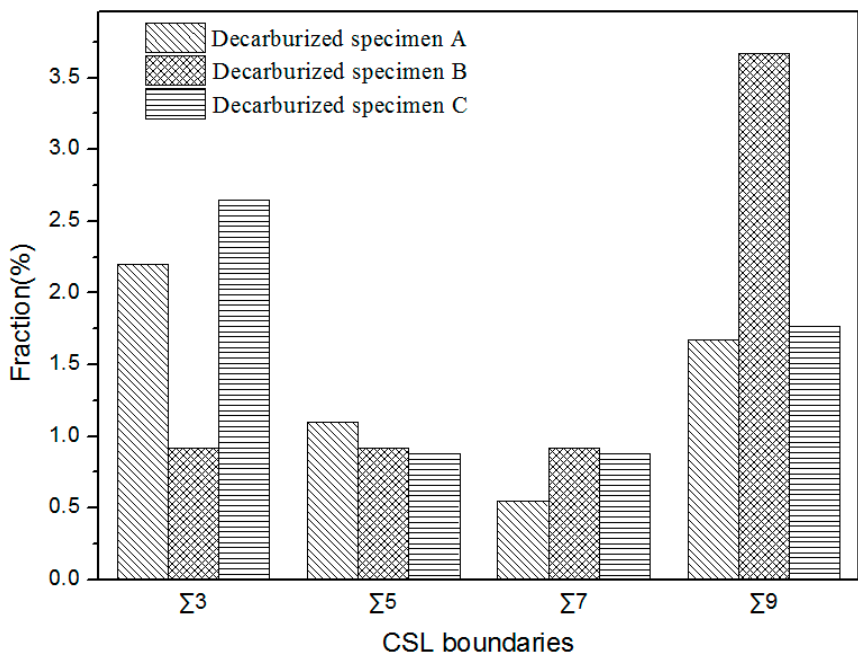
Figure 11. Variety of CSL grain boundaries in different specimens.